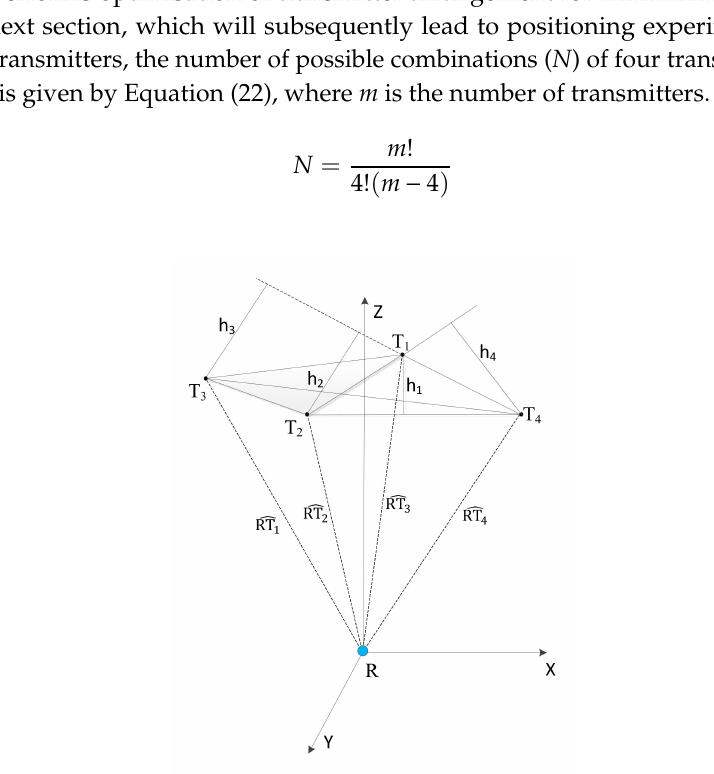
Figure 6. Tetrahedron formed by joining unit vectors from the receiver to the four